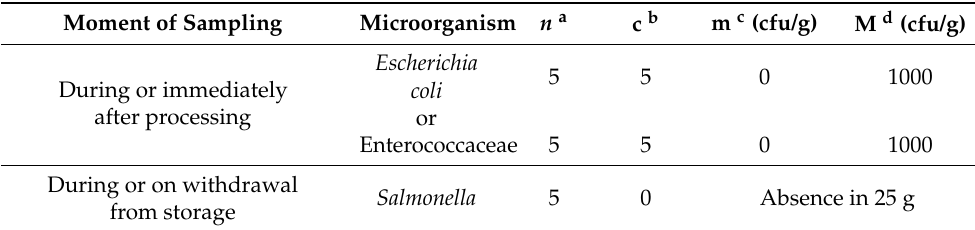
Table 1. Microbiological standards applying to the placing on the EU market of processed (digestion into biogas or composting) manure (Regulation (EU) No. 142/2011) [18]. Moment of Sampling Microorganism n a c b m c (cfu/g) M d (cfu/g) Escherichia 5 5 0 1000 During or immediately coli after processing or Enterococcaceae 5 5 0 1000 During or on withdrawal Salmonella 5 0 Absence in 25 g from storage a number of tested samples; b number of samples of which the bacterial count may be between m and M; c threshold value (i.e., lower limit) for the number of bacteria in the sample; d maximum value (i.e., upper limit) for the number of bacteria in the sample. If one sample exceeds M, the sampled batch is considered as insufficiently processed and regarded as unprocessed